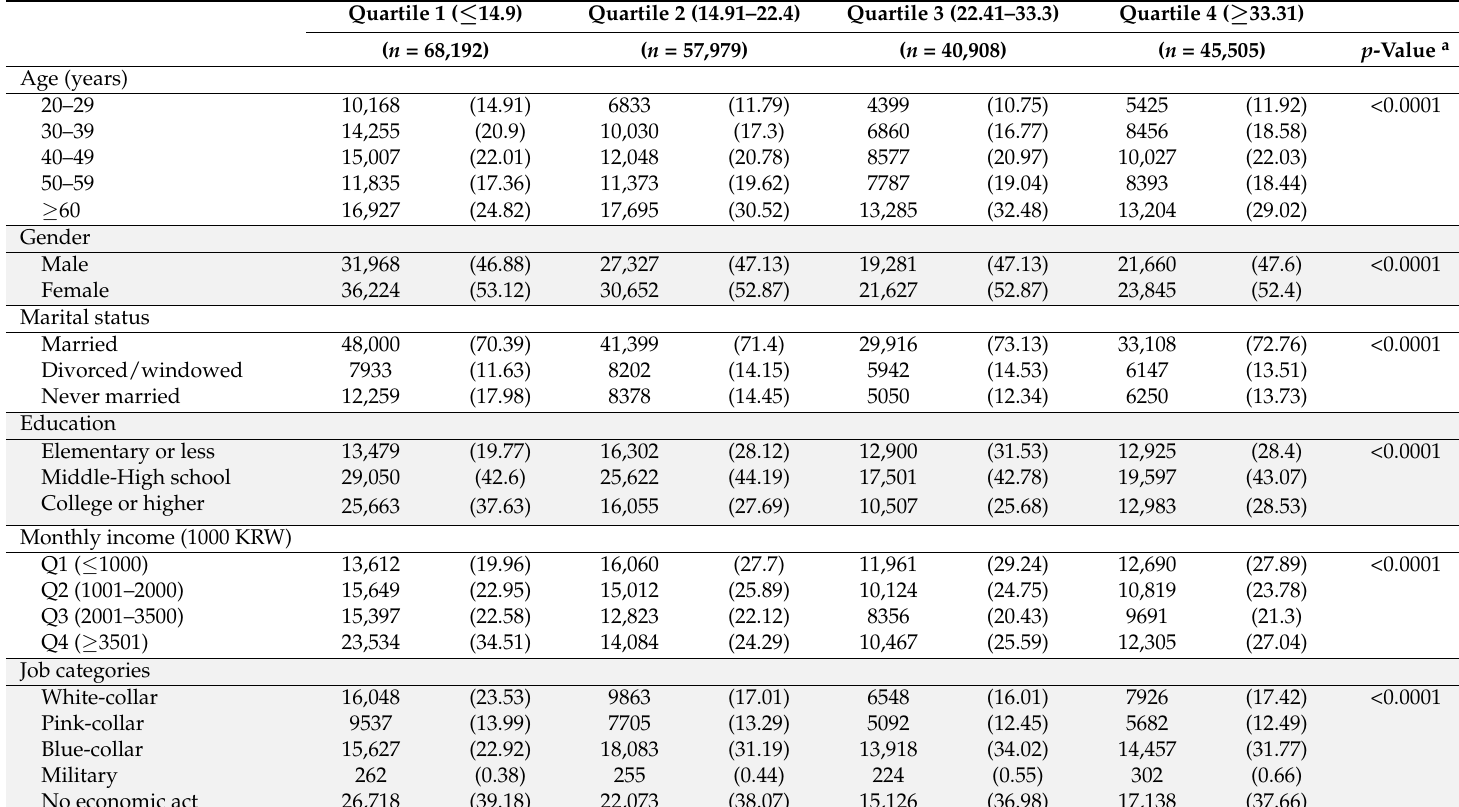
Table 1. Characteristics of the study population based on quartiles of parks and green area (m 2 per capita) n